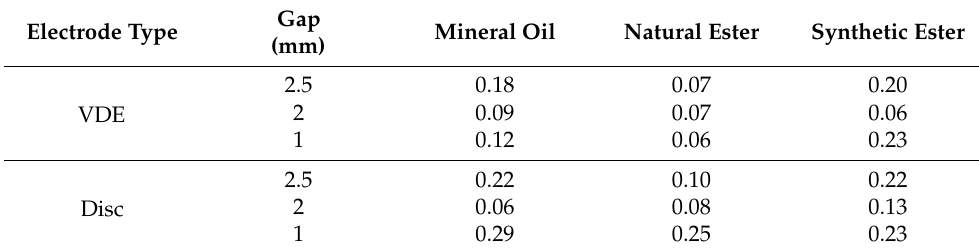
Table 9. Standard deviation/BDV ( s / x ) for negative DC BDV test